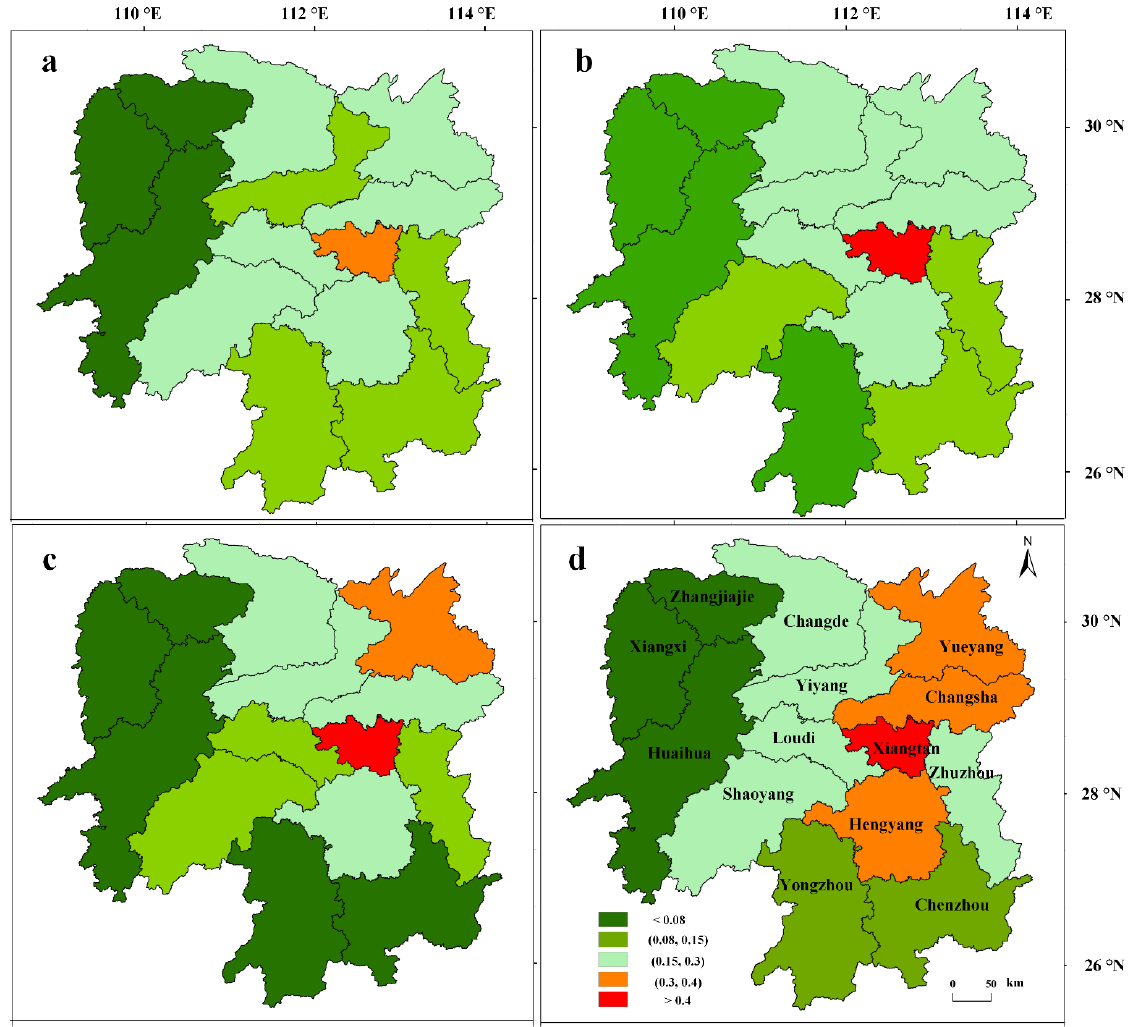
Figure 8. Spatial patterns of per capita water ecological pressure index (WEPI) in 2010 ( a ), 2015 ( b ), and 2019 ( c ), and the average from 2010 to 2019 ( d ).